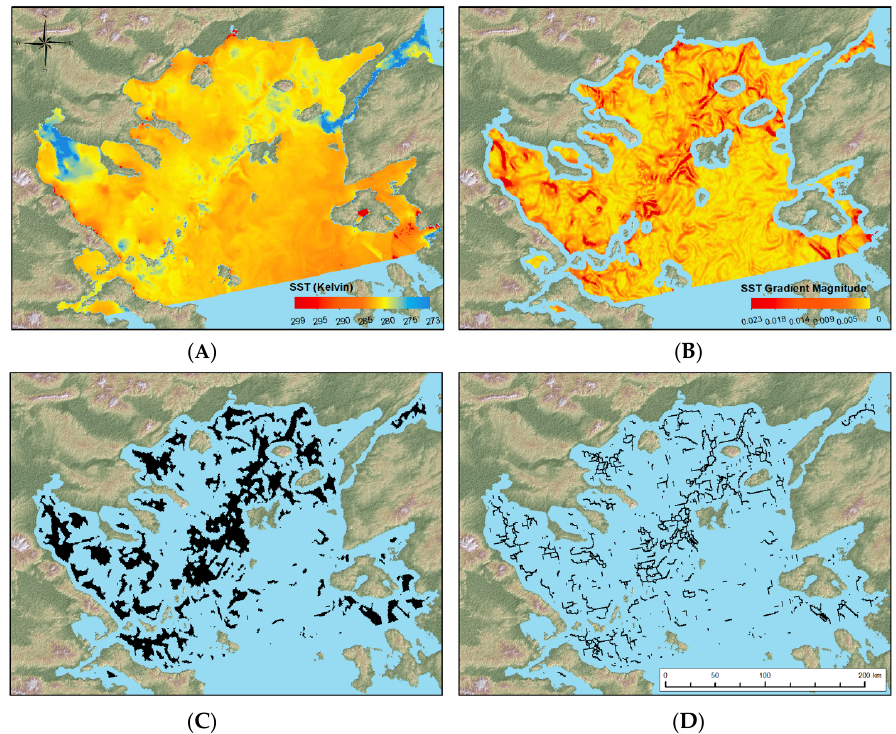
Figure 5. Results from 07/05/2020: ( A ) Interpolated SST data; ( B ) SST Gradient Magnitude; ( C ) Binary Image after threshold application and morphological closing; ( D ) Detected thinned oceanic features.